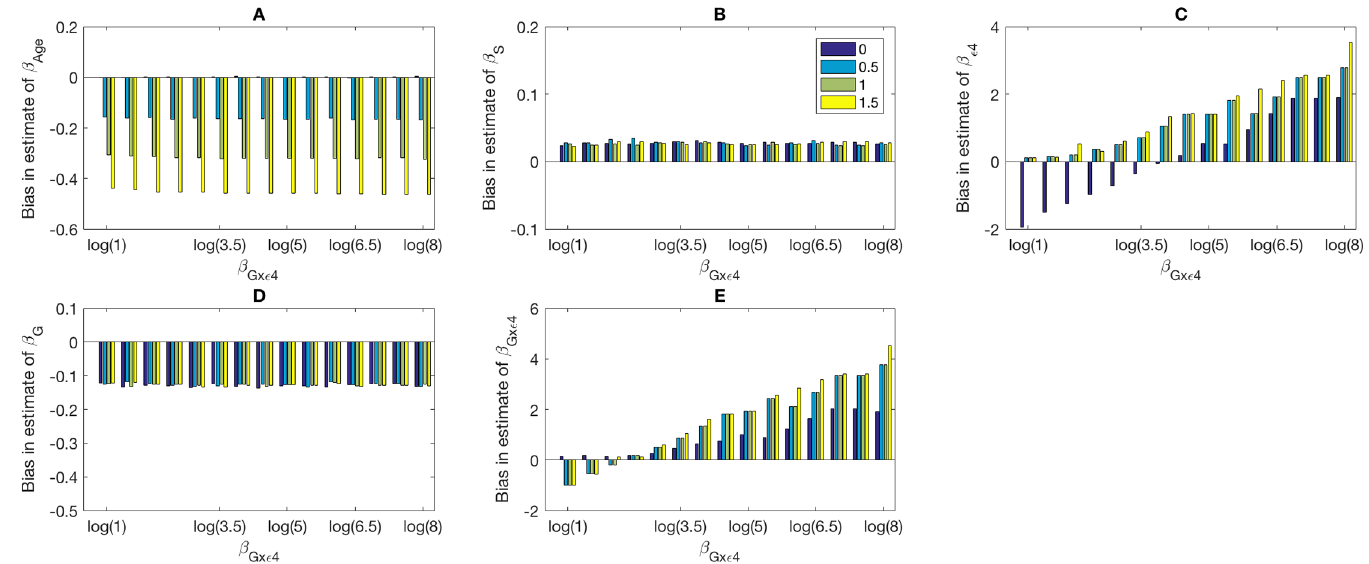
Fig 2. The bias in estimates of β ( β Age ) (A), β ( β Sex ) (B), β ε 4 (C), β G (D), and β G × ε 4 (E) obtained using the usual logistic regression with clinical diagnosis as the Z 1 Z 2 outcome across values of β G × ε 4 . Simulated are datasets with 3,000 cases and 3,000 controls. Values of β G × ApoE 4 are listed along the x-axis and the true values of b indicated by color. The parameters are set as follows: β 0 = − 1, β = log(1.5), b ¼ (cid:0) 0 : 083 ; β = log(3); the relationship between the clinical and true disease statuses is G G × ε 4 X 2 pr(D = 1 (cid:3) | D CL = 1, ε 4-) = 0.36 and pr(D = 1 (cid:3) | D CL = 1, ε 4+) = 0.06. Variables G , Z 1 and Z 2 are Bernoulli with frequencies 0.10, 0.50 and 0.52, respectively.